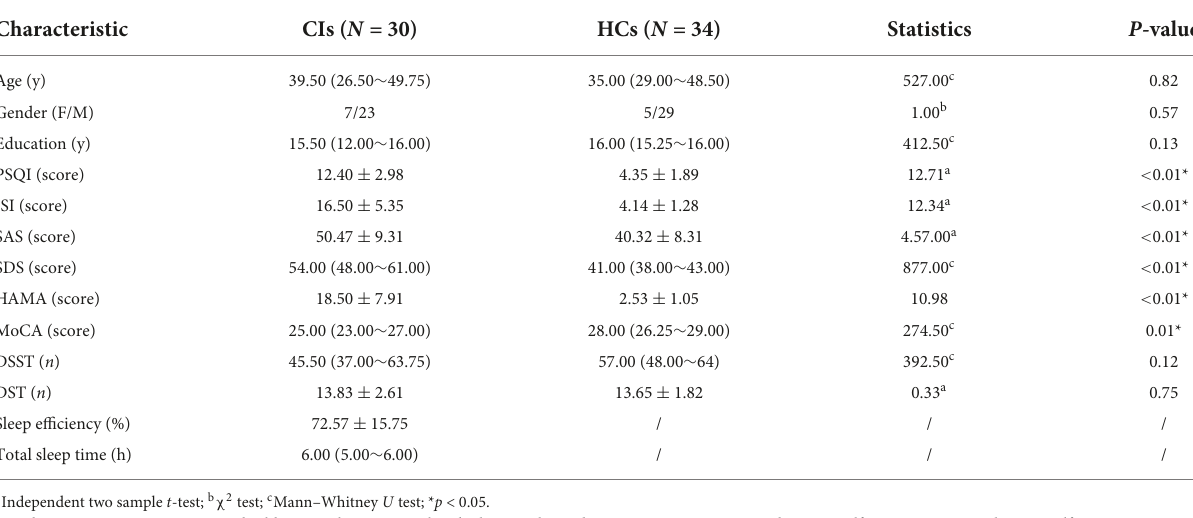
TABLE 1 Demographics and clinical characteristics of CI patients and HCs.